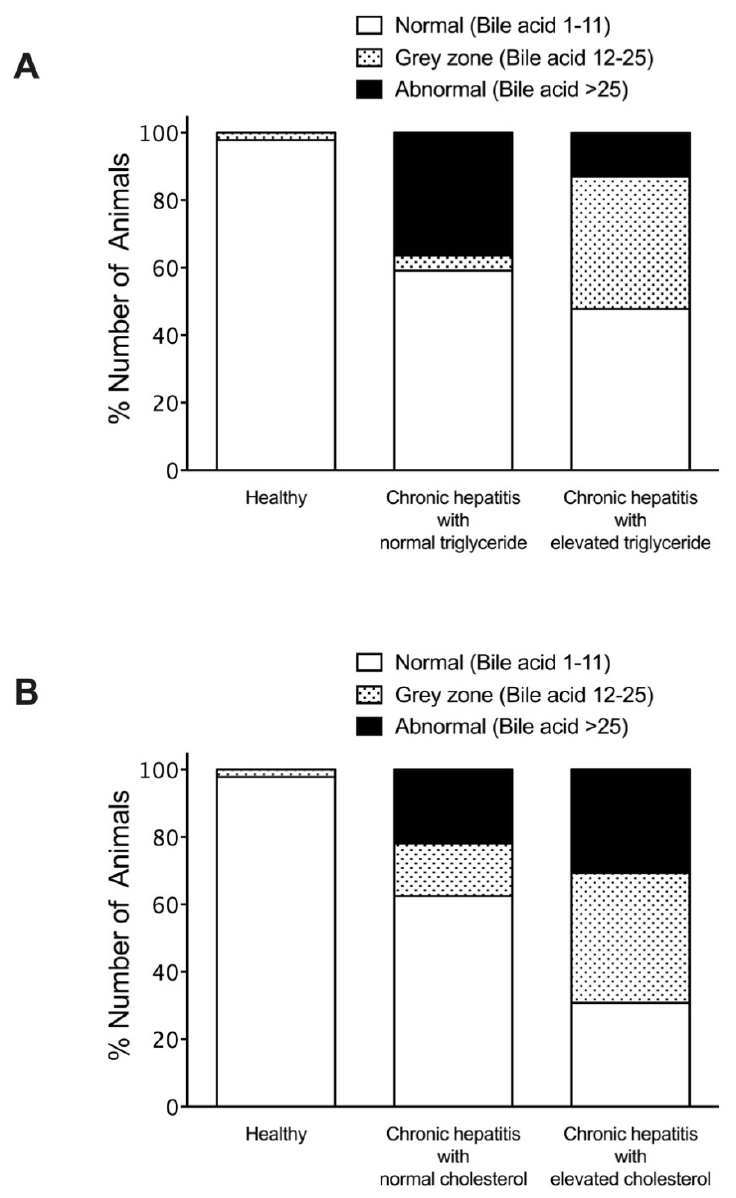
Figure 5. Histogram illustrating preprandial serum bile acid concentrations of healthy and dogs with chronic hepatitis, classified by triglyceride ( A ) or cholesterol levels ( B ). The magnitude of serum bile acid was divided into normal (1–11), inconclusive (grey zone) (12–25), and abnormal (>25). Table 3. Pairwise correlation analysis among biochemical values for ALT, ALP, GGT, bile acid, and cholesterol. ALT ALP GGT Bile Acid Cholesterol Triglyceride 0.0016 0.2582 * − 0.0325 0.0855 0.2442 * Cholesterol 0.8287 ** 0.8436 ** 0.5640 ** 0.3310 **